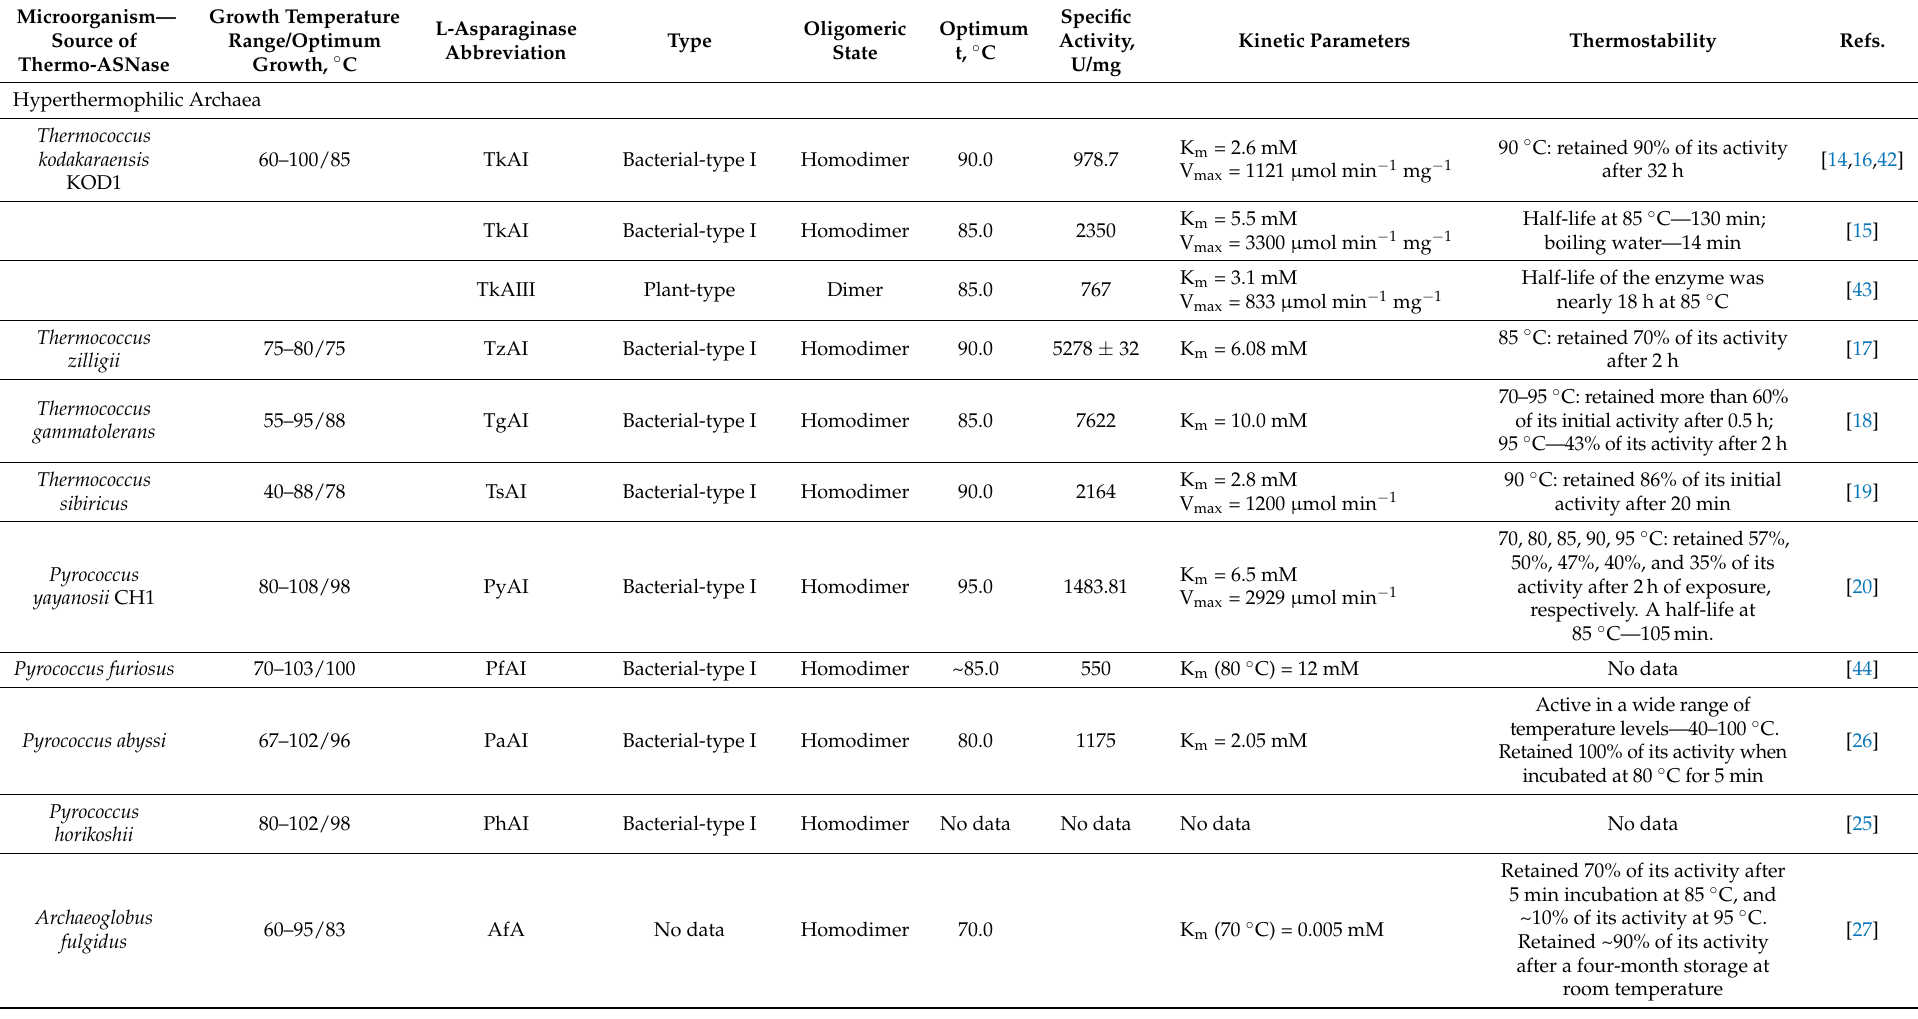
Table 1. Summary of thermo-ASNases: producing microorganisms, types, main